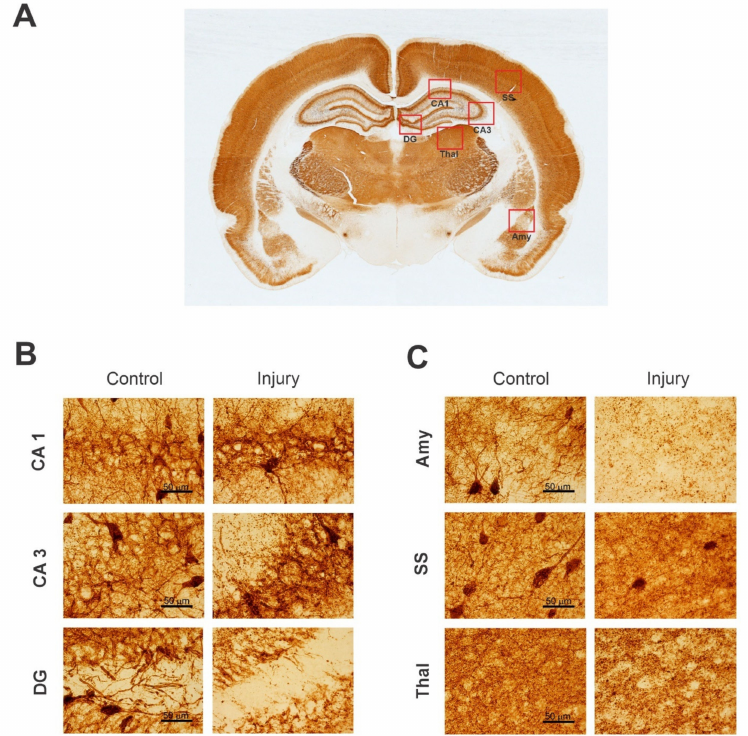
Figure 3. PV(+) immunostaining of inhibitory interneurons in the brain . Representative images of PV(+) inhibitory GABAergic interneurons in the brain sections of DFP chemically injured